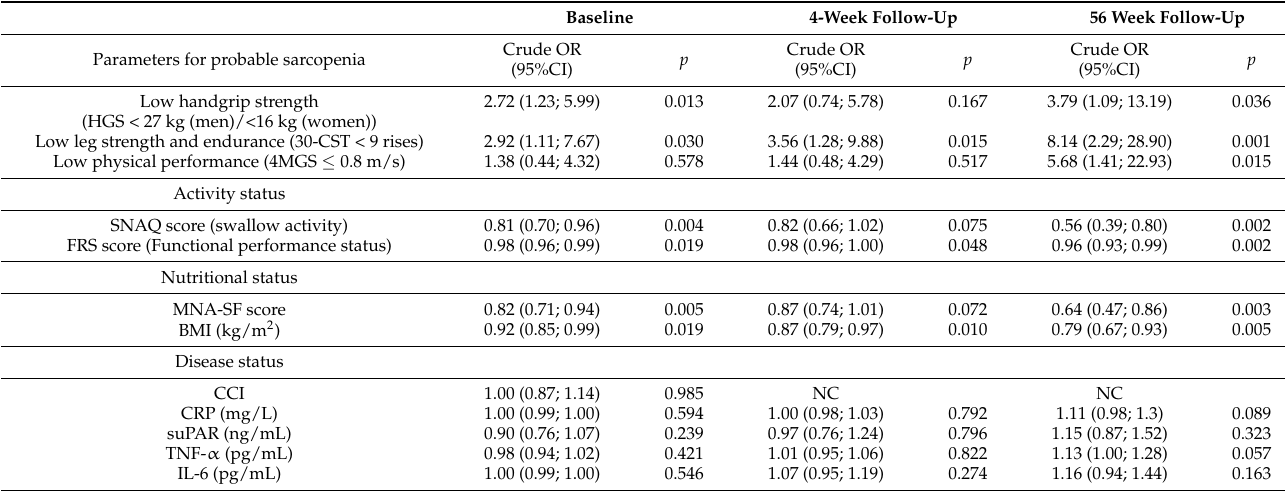
Table 3. Association of signs of dysphagia with parameters for probable sarcopenia and activity, nutritional, and disease status at three time points Baseline 4-Week Follow-Up